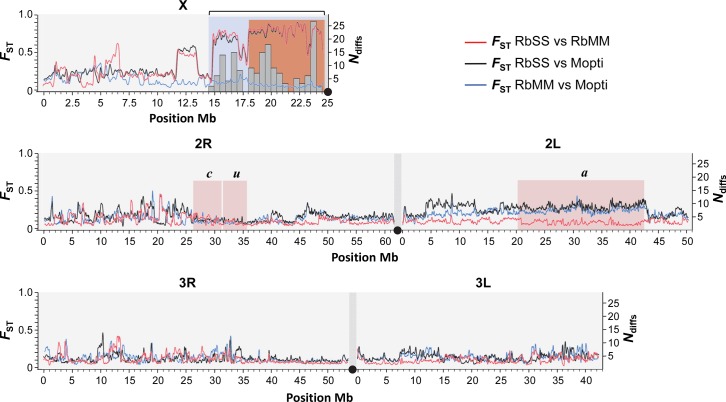
Genomic structure of recombinant strains.The genomes of the assortatively-mating RbMM, RbSS and parental Mopti strains were compared using F
ST estimates at ~3x106 SNP marker loci (left Y-axis and red, blue and black lines). The genomic region introgressed from Kisumu into the Mopti genetic background and differing between the RbMM and RbSS recombinant strains is characterized by high F
ST values (blue shade) and extends from position ~14.5Mb to the centromere on chromosome X. The RbMM and RbSS differed at 160 protein-changing positions all of which located within the introgressed island and flanking region (right Y-axis, grey histogram bars). The pericentromeric region sharing conserved fixed differences with the field Anopheles coluzzii and gambiae s.s populations starts at position ~18.1Mb (orange shade). The position of inversions c, u and a on chromosome 2 is indicated (pink shade).